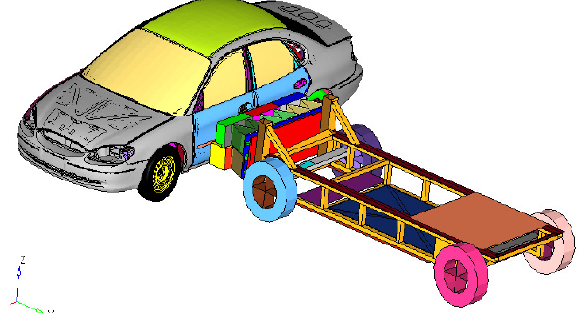
Figure 4. Car model for side impact design problem